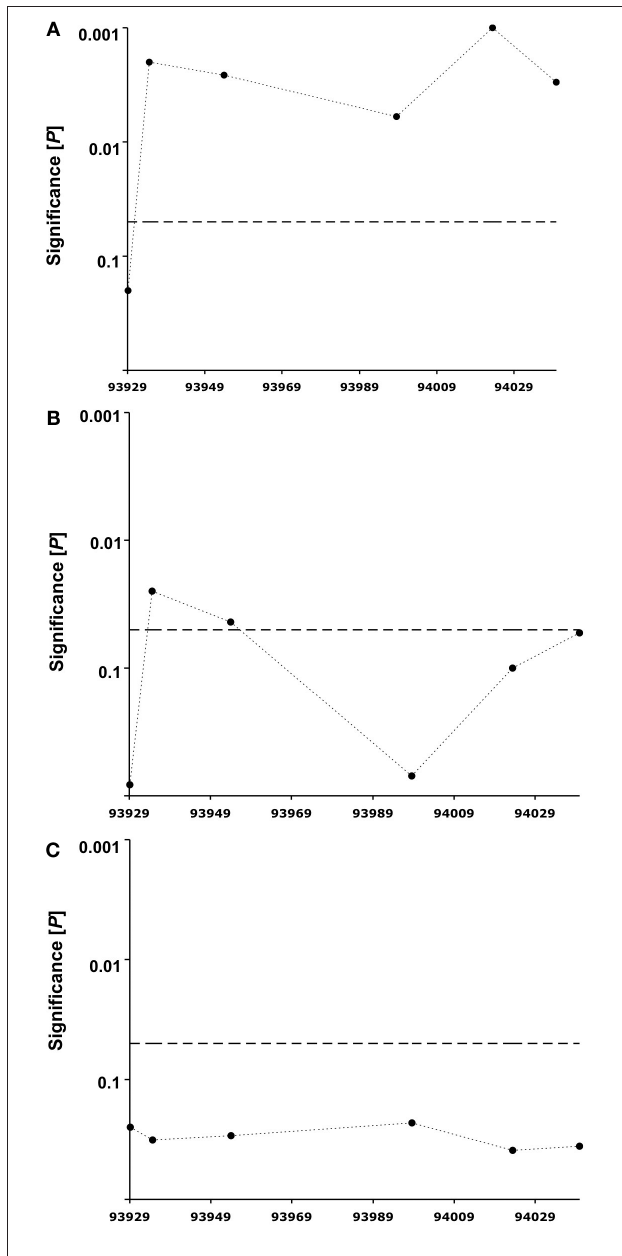
FIGURE 3 | Signifi cance of association of human CPEB3 SNPs with episodic memory performance. (A) Words with positive valence, (B) words with negative valence, (C) words with neutral valence. Analyzed SNPs (3 ′ to 5 ′ direction): rs7071217, rs3781230, rs11186856, rs11186872, rs17107517, rs11186898. The dotted horizontal lines indicate the 5% signifi cance level. The x -axis represents the chromosomal position of the SNPs in